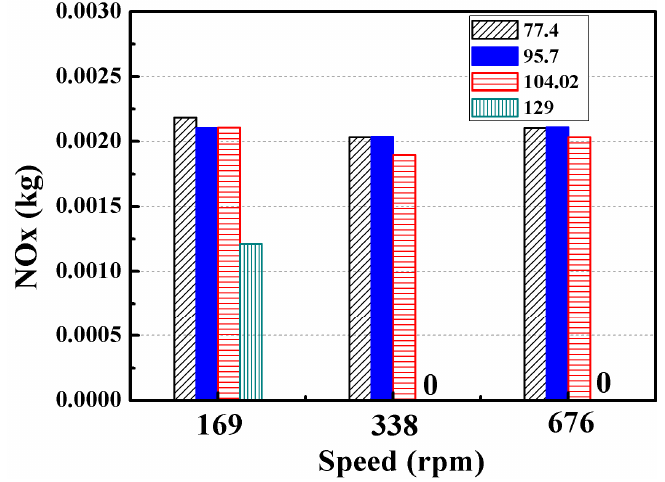
Figure 11. NO x of marine engine fueled with HFO at different engine speeds.